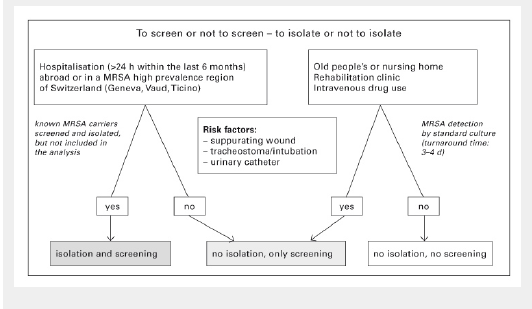
Figure 1 Algorithm to decide whether to screen/isolate for MRSA at